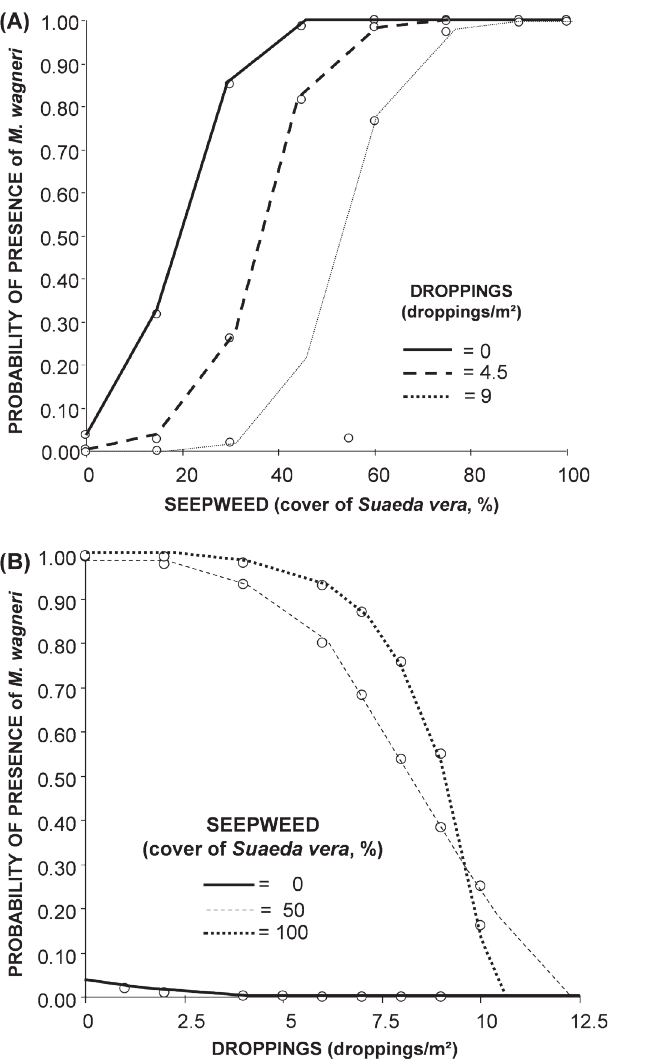
Fig. 5. Relationship between number of Mioscirtus wagneri per square meter (ABUNDANCE) and A. Cover (%) of Suaeda vera (SEEPWEED), and B. Livestock droppings per square meter (DROPPINGS). Open circles may correspond to one or more overlapping data